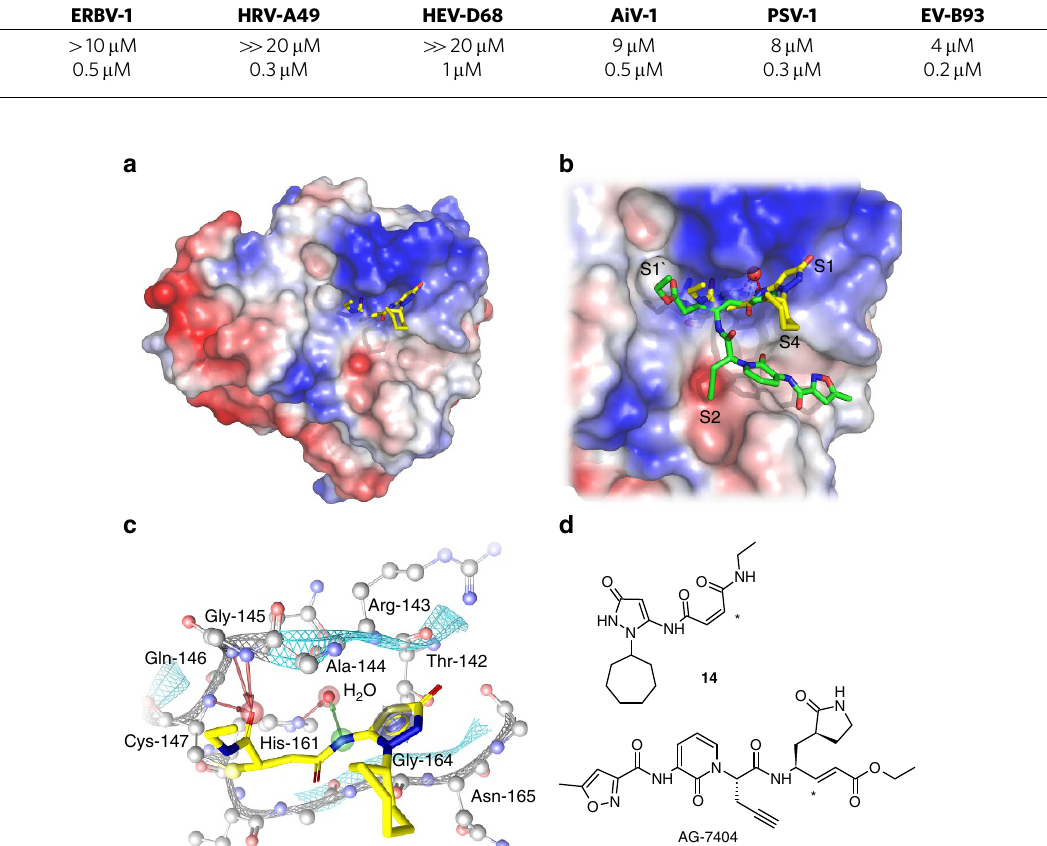
Figure 6 | Crystal structure of inhibitor 14 with 3C protease of EV-B93 (PDB: 5IYT). ( a ) Refined structure of the enzyme–inhibitor complex with 14 represented as sticks, carbon atoms in yellow. ( b ) Close-up of the substrate - binding site with bound 14 and AG-7404 (carbon atoms in green); sub- pockets S1’, S1, S2 and S4 are annotated. Water molecules are represented as red spheres. ( c ) Binding modes of 14 ; EV-B93 3C amino-acid residues in close proximity to 14 are labelled in the S1 and S1’ sub-pockets. The arrows represent the H-bonds between 14 , water molecules crucial for inhibitor binding and the protein. ( d ) Structures of inhibitors 14 and AG-7404 with the carbon covalently attacked by the sulfur nucleophile of the protease being highlighted by an